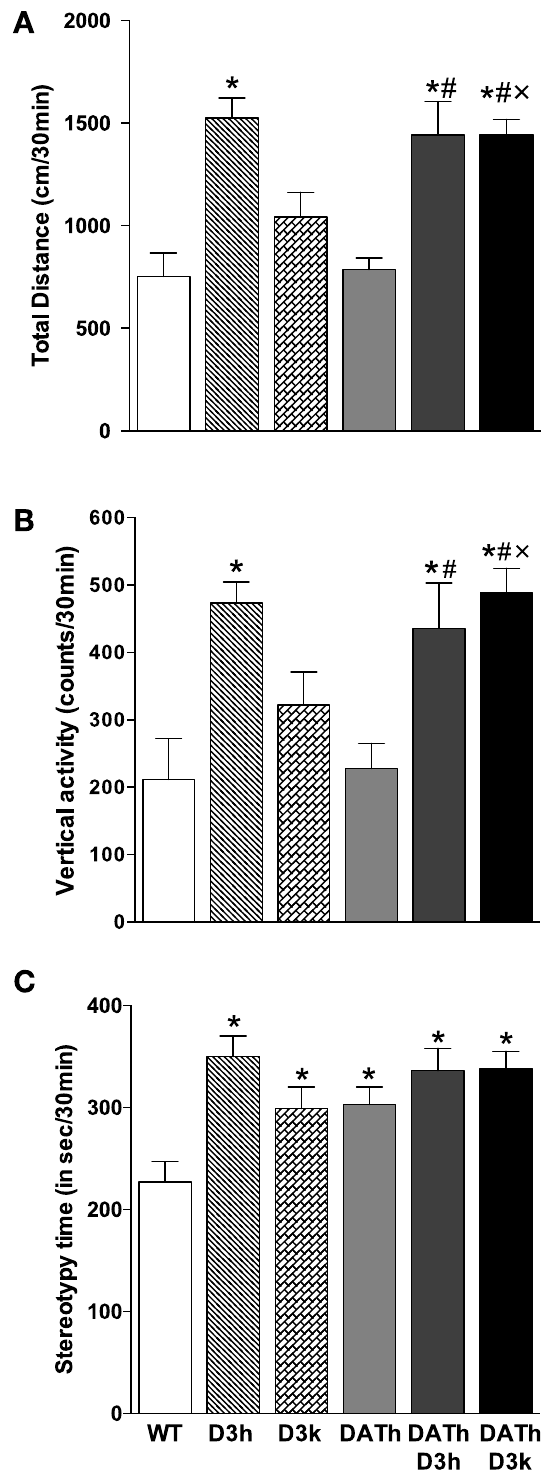
Figure 3. Parameters of locomotor activity of wild type, DAT, and D3 single mutants and DAT / D3 double mutants. Values represented in mean ± S.E.M. ( A ) Total distance shown in cm traveled in 30 min ( B ) vertical activity counts in 30 min ( C ) stereotypy in a total time of stereotypical movement in 30 min. By comparison, the DATk group demonstrated extreme hyperactivity (total distance 8672 ± 1348 cm / 30 min; vertical activity 1333 ± 304 counts / 30 min; stereotypy time 741 ± 50 s / 30 min) with all parameters being significantly di ff erent from WT controls ( p < 0.05). * p < 0.05 vs. WT controls; # p < 0.05 vs. DATh group; × p < 0.05 vs. D3k